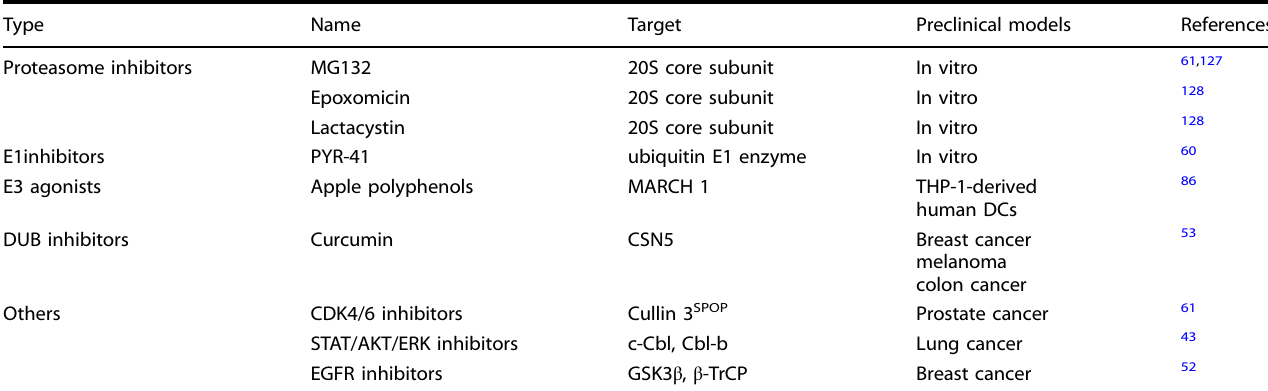
Table 4. Drugs that may regulate the immune checkpoint pathways through targeting ubiquitination/deubiquitination (preclinical) Type